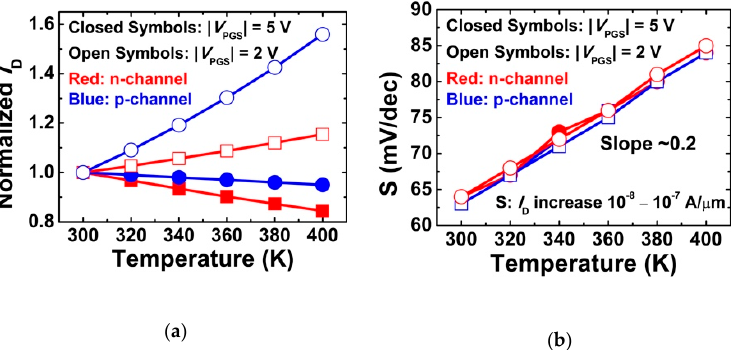
Figure 3. Extracted parameters from I D – V PGS curves. ( a ) Normalized I ON by I ON at 300 K. I ON is extracted when V PGS is 1.5 V; ( b ) subthreshold swing ( S ). The extracted S is exactly sitting on the 2.3k B / q -slope (~0.2 mV/K) line.